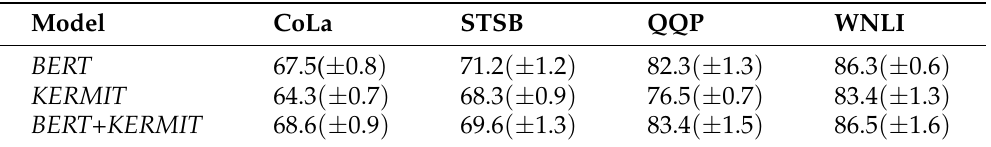
Table 1. Comparison of different performances on GLUE task. The experiments were run five different times with different